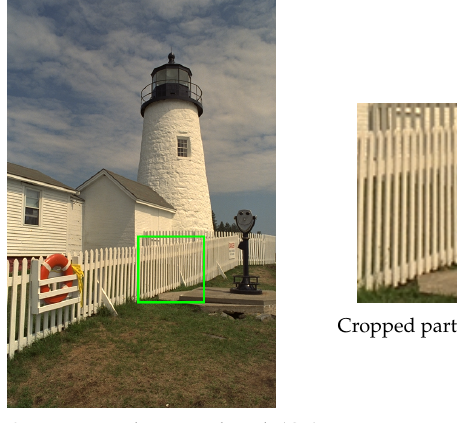
Figure 10. Examples of ground truth images from KODAK and IMAX image data-sets and their cropped